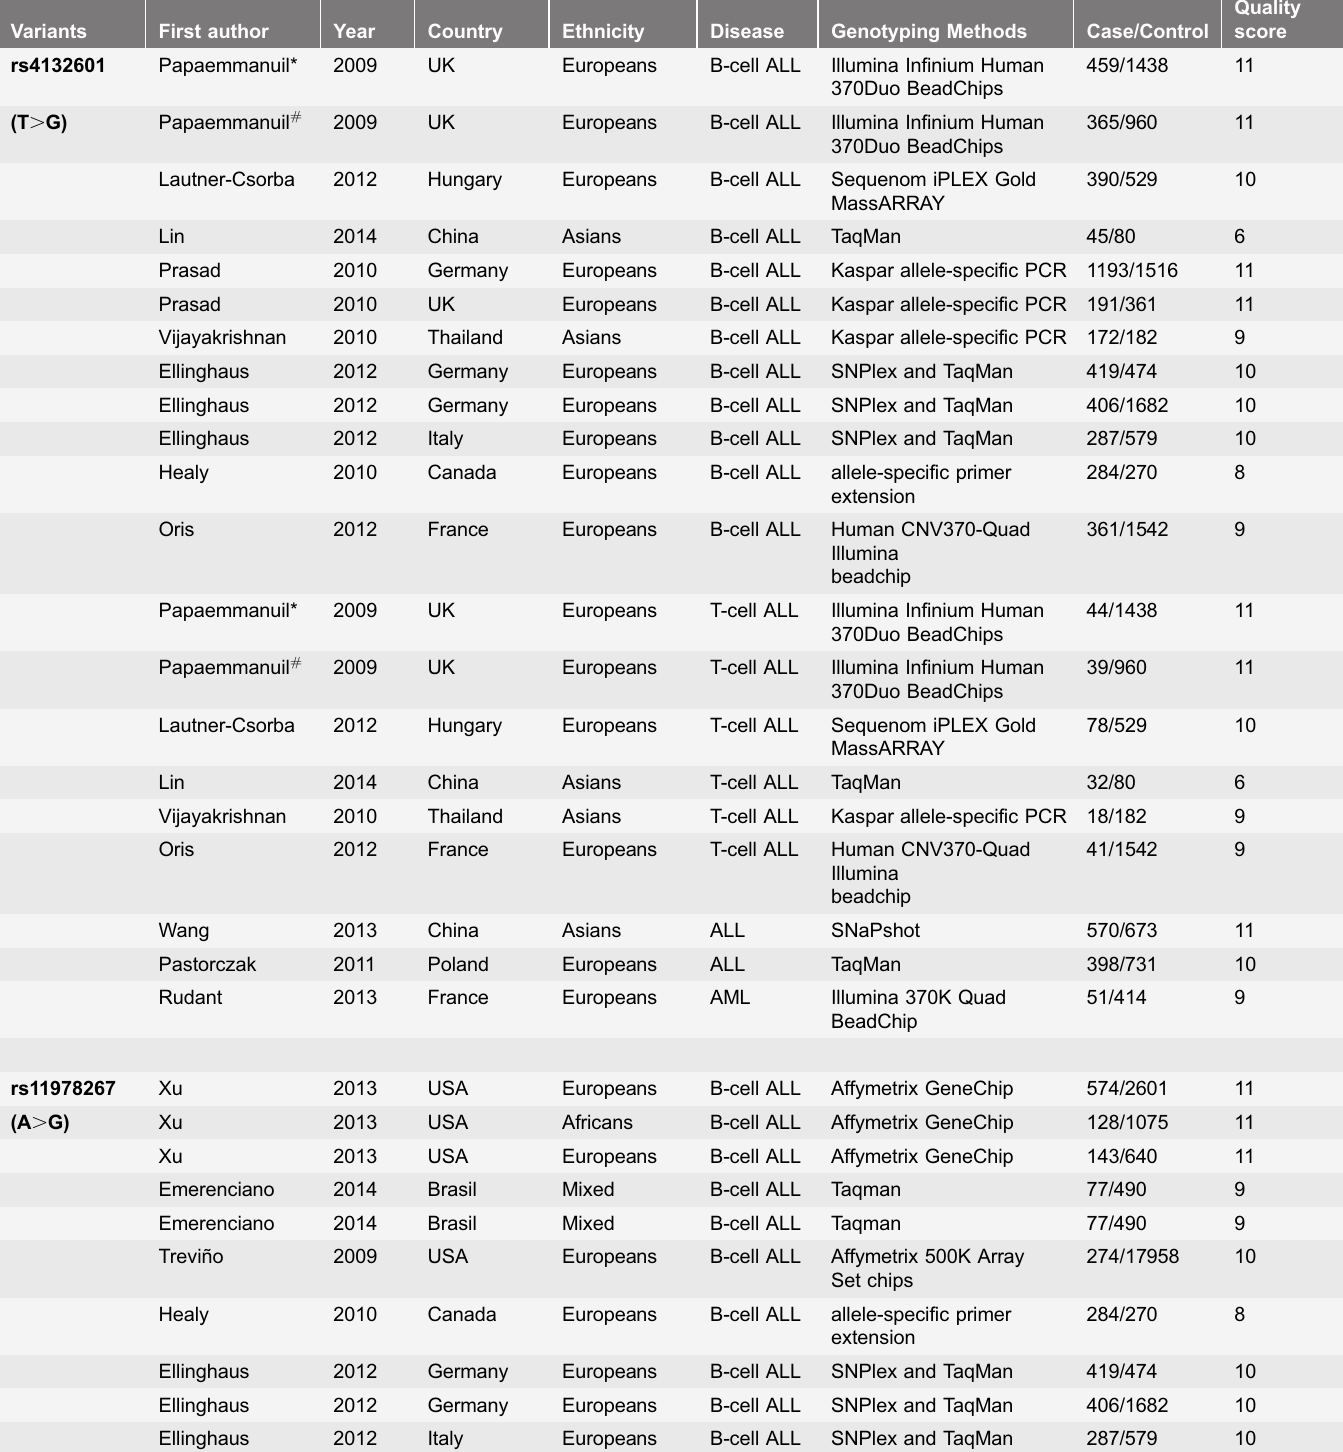
Table 1. Characteristics of studies included in the